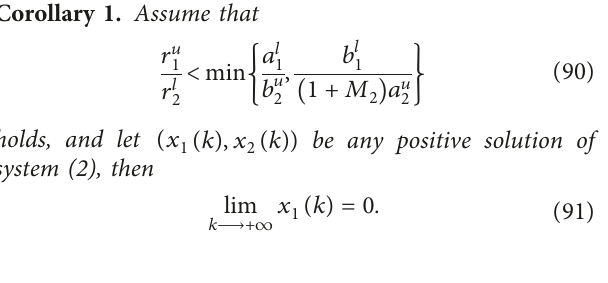
0 . 3 , 0 . 2 , 2 . 7 , 0 . 4